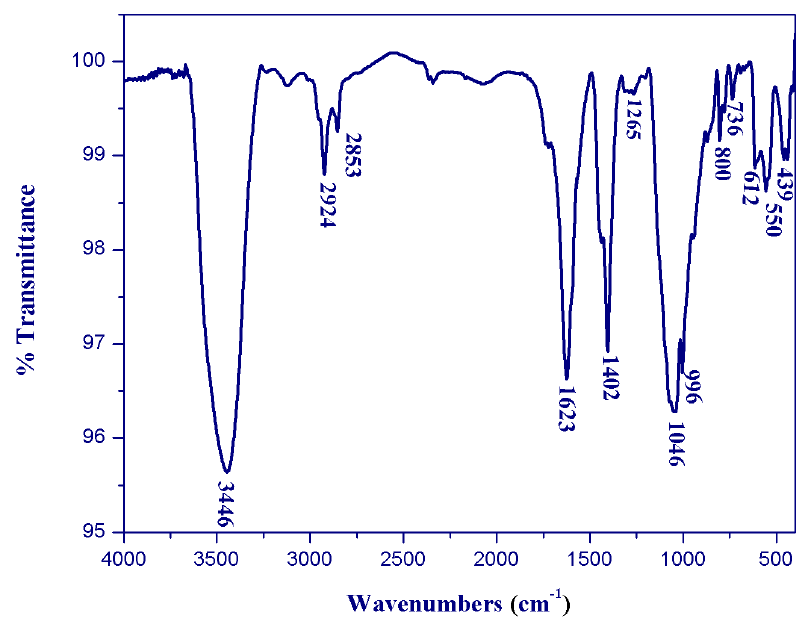
Figure 11. Vibrational spectrum of Bi 4 I 16 · 4(C 6 H 9 N 2 ) · 2(H 2 O).